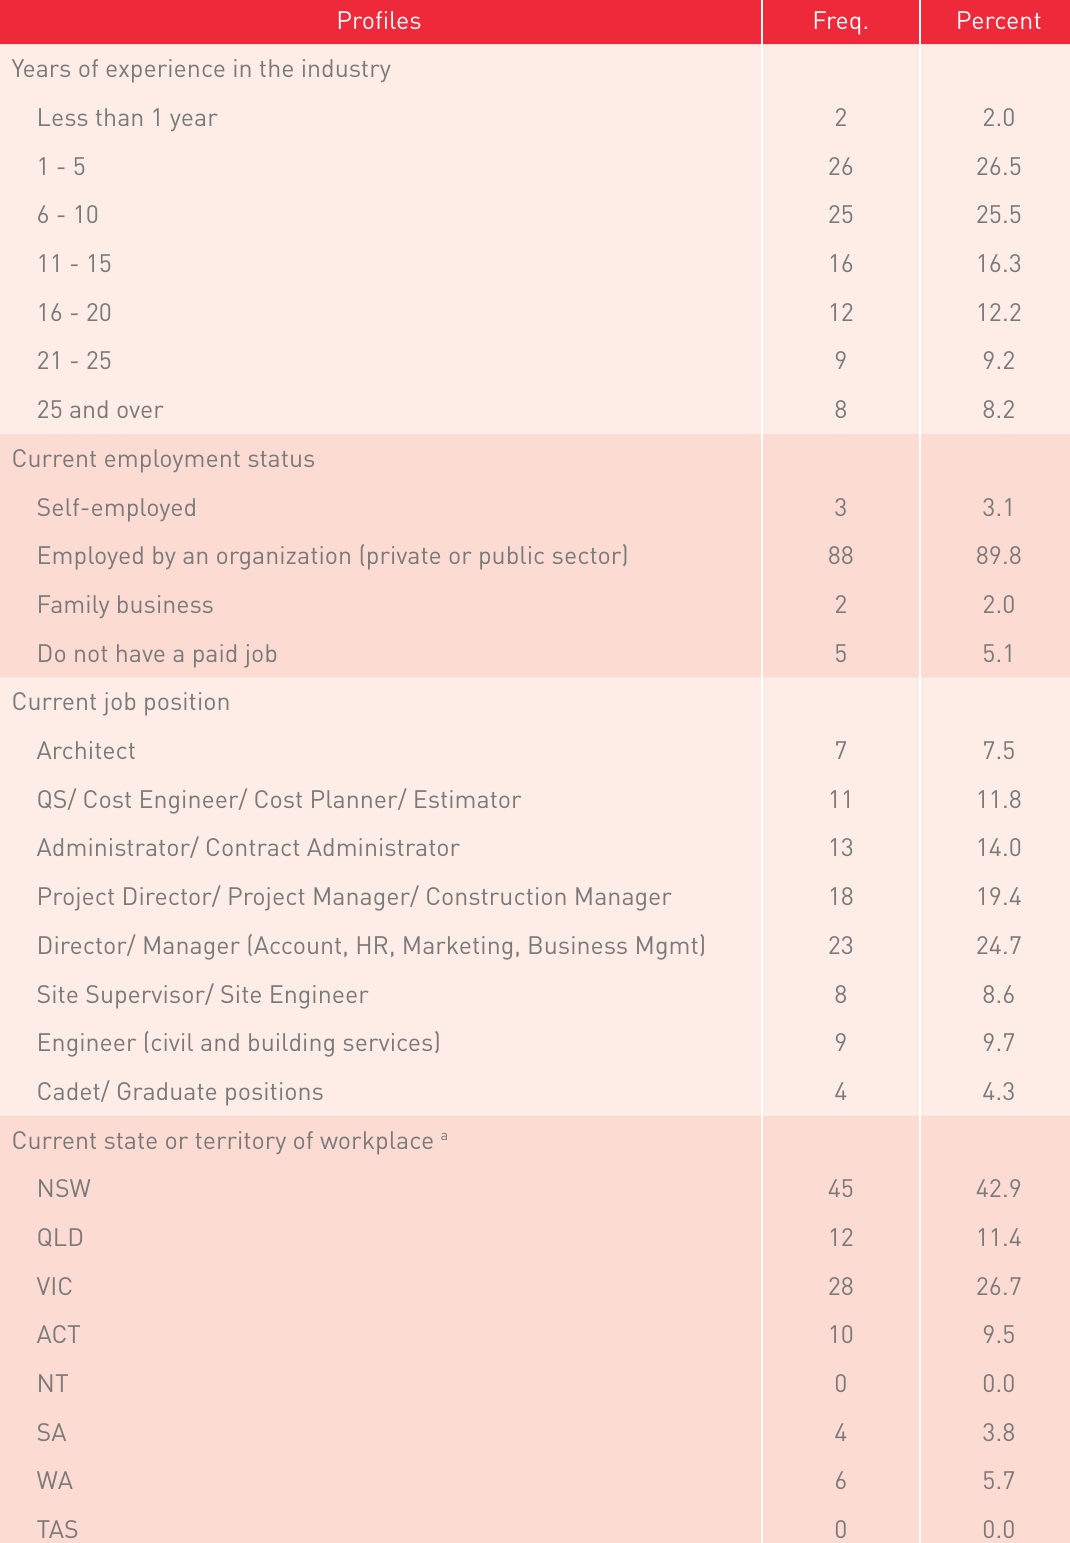
The employment profiles of the